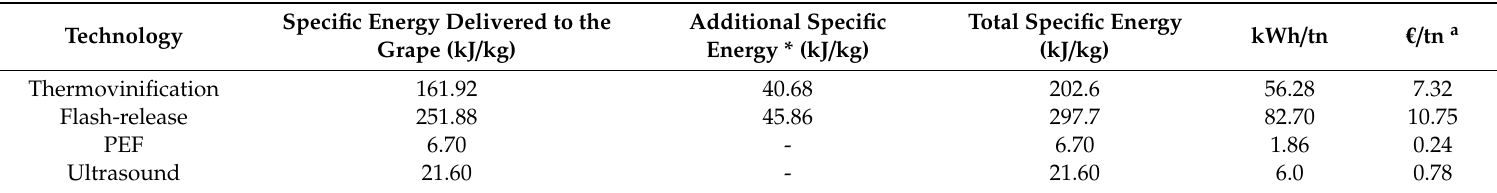
Table 3. Estimation of the energetic costs of thermal and non-thermal physical methods for improving polyphenol extraction during